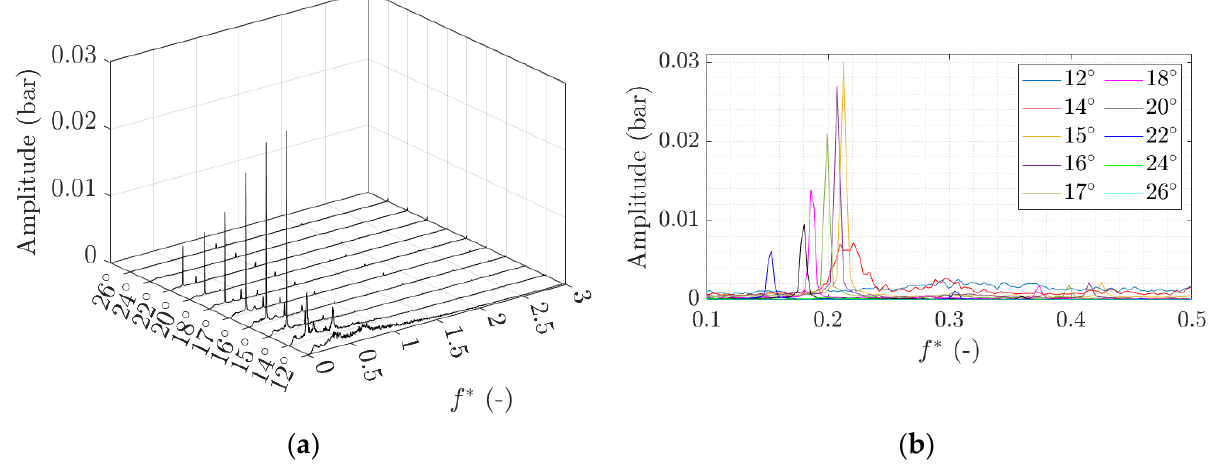
Figure 4. Spectra of the draft tube pressure pulsations (P1x 0° ) at α from 12° to 26° ( a ) and a zoomed in around RVR peak ( b ).